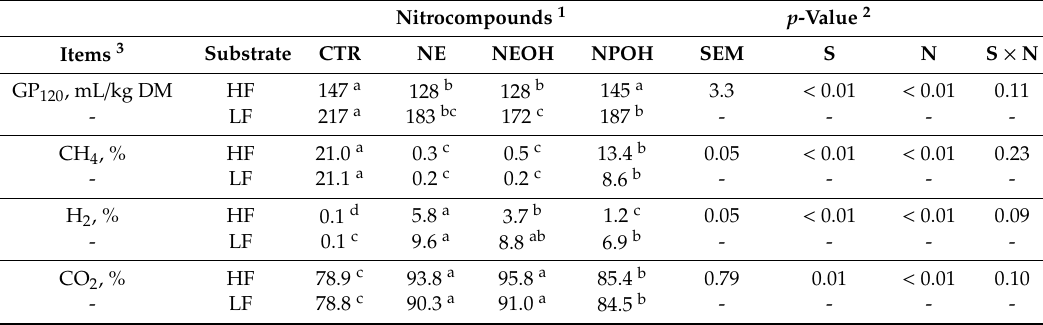
Table 2. E ff ect of 10 mM addition of nitroethane (NE), 2-nitroalcohol (NEOH), and